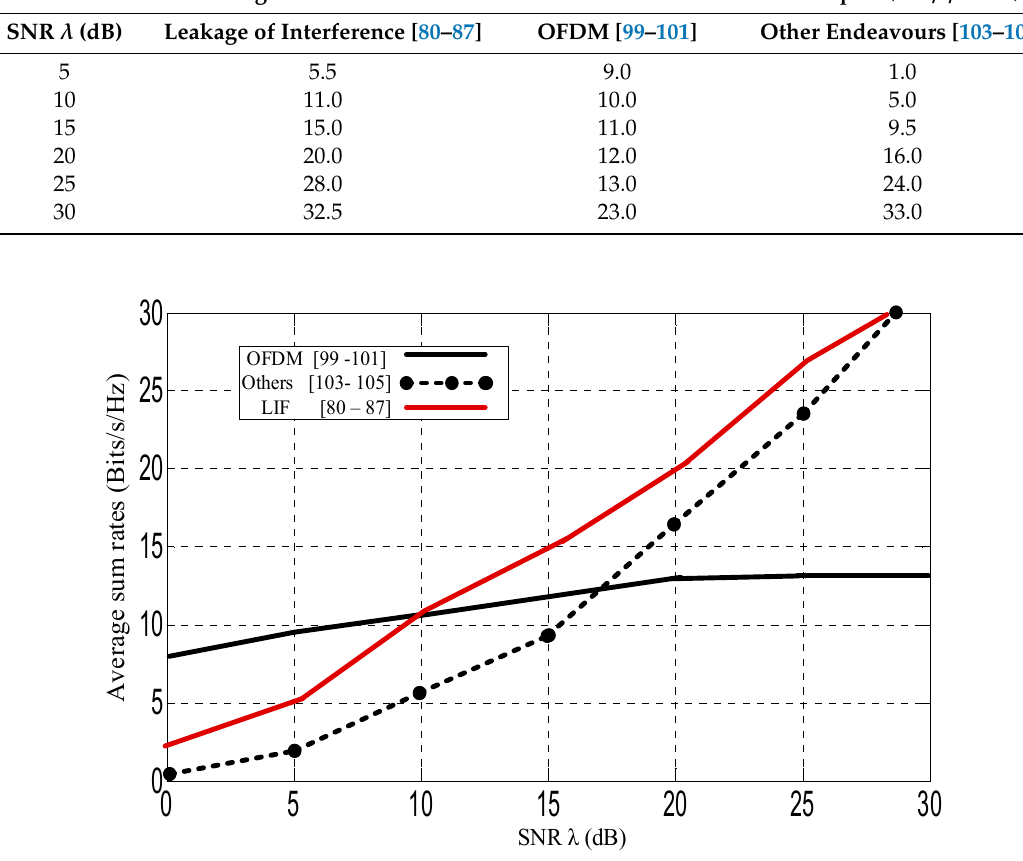
Figure 6. Average sum rates against typical SNR values for the first paradigm [80–87,99–101,103–105].